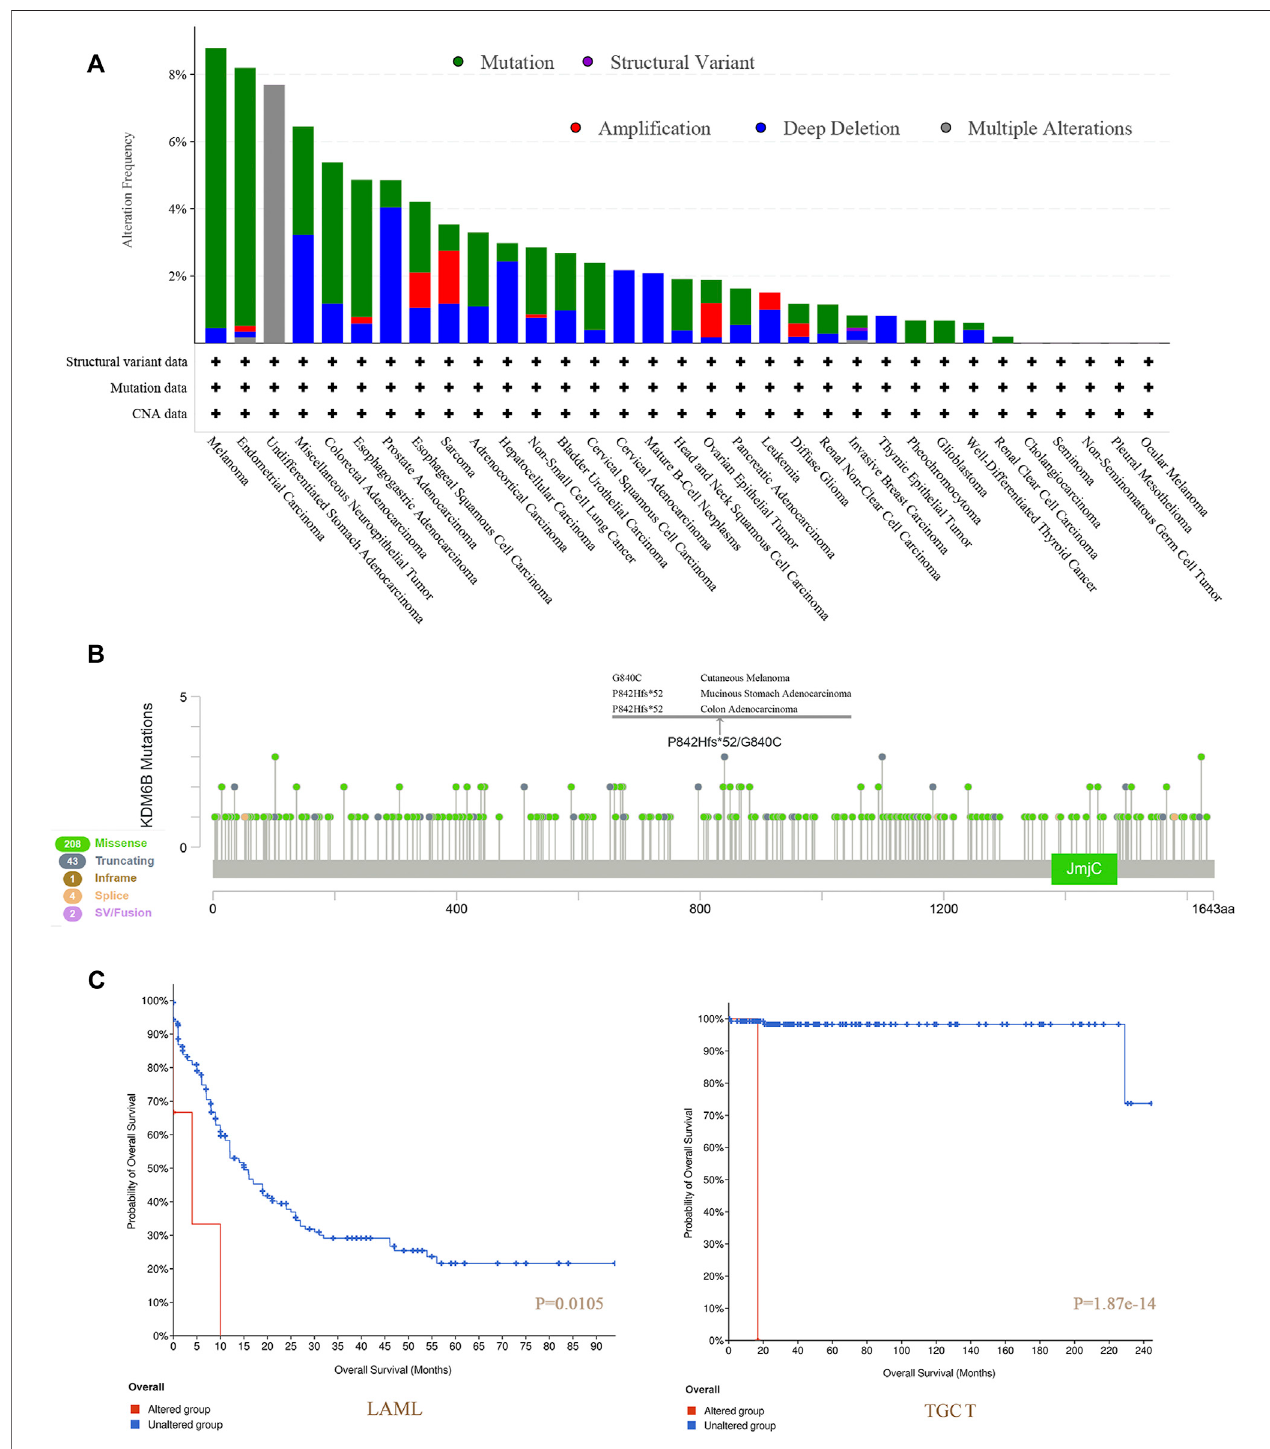
FIGURE 4 | Mutation features of KDM6B in different tumors of TCGA. We analyzed the mutation features of KDM6B for the tumors in TCGA dataset using the cBioPortal tool. The alteration frequencies with mutation type (A) and mutation site (B) are displayed. We also analyzed the potential correlation between the mutation status and overall survival of LAML and TGCT (C) using the cBioPortal tool.